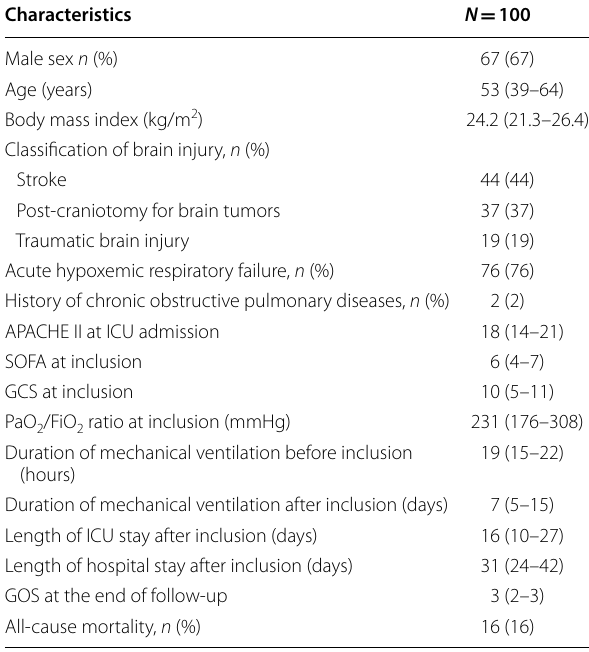
Table 1 Characteristics of the